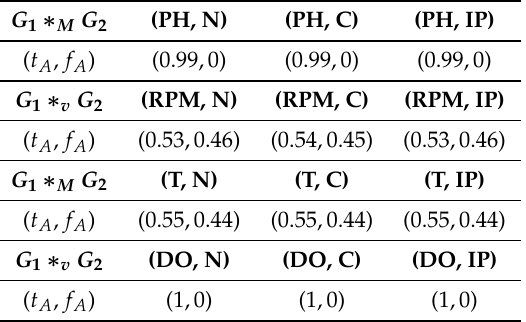
Table 6. Degree of vertices in vague graph G 1 ∗ M G 2 .